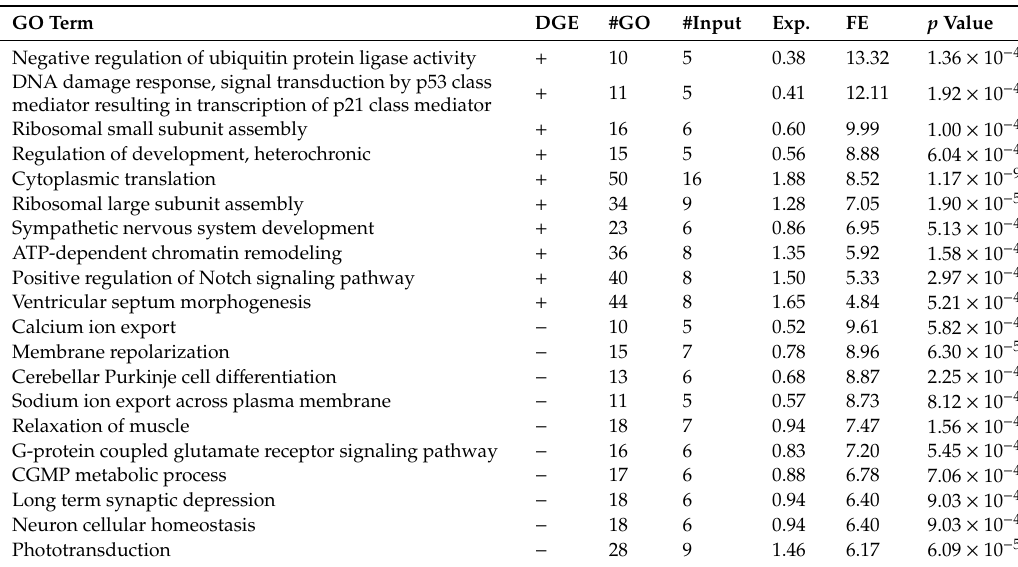
Table 3. Top 10 enriched GO terms of up- and downregulated genes in PN5 Lgr5 + cells compared to adult Lgr5 + . DGE: Input from up ( + ) or downregulated ( − ) genes from di ff erential gene